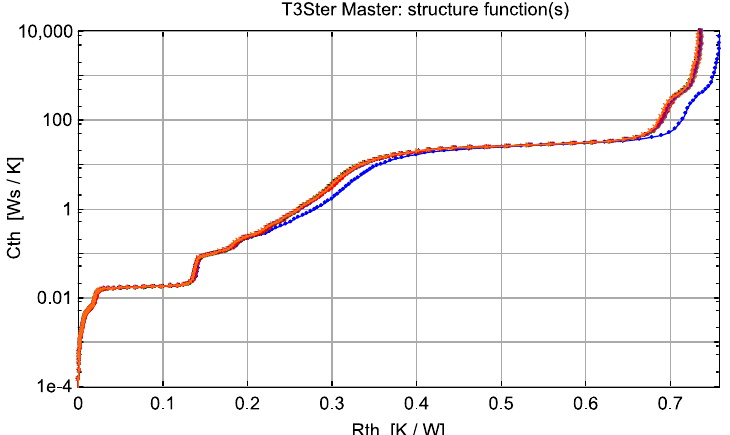
Figure 9. Structure function of Sample 1 in the initial state (blue) and after every 1000 cycles (red, black, etc., overall 9 curves).